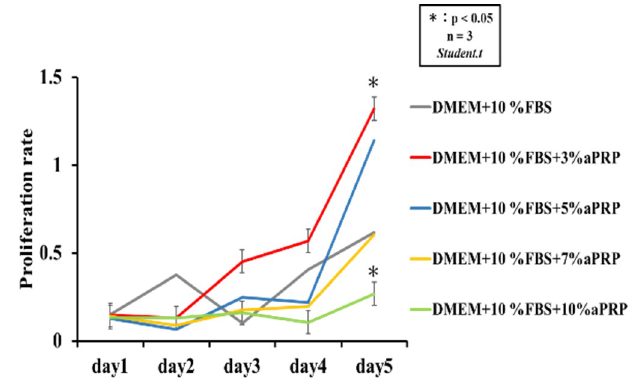
Figure 8. Proliferation of rat dedifferentiated fat cells across 5 days after the addition of various concentrations of activated platelet-rich plasma (aPRP). DMEM: Dulbecco’s modified Eagle’s medium, FBS: fetal bovine serum.